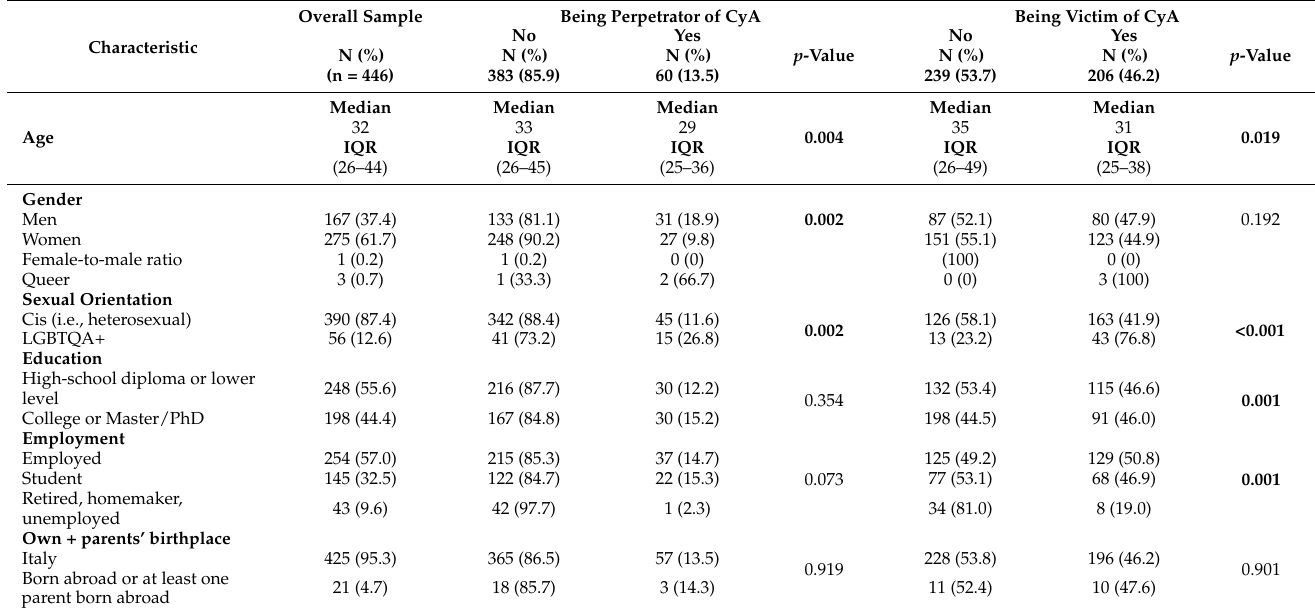
Table 1. Sociodemographic characteristics and relationships with primary outcomes.